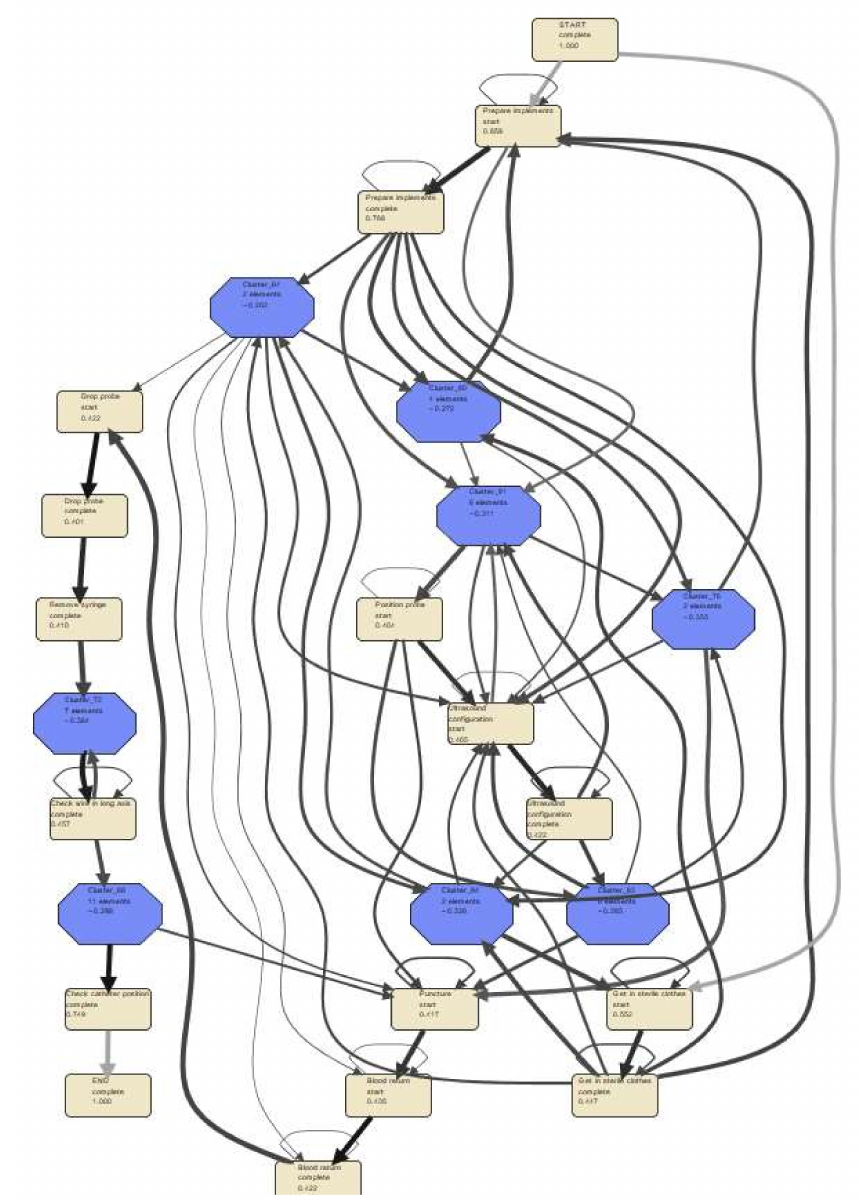
Figure 4. Process modeling with fuzzy